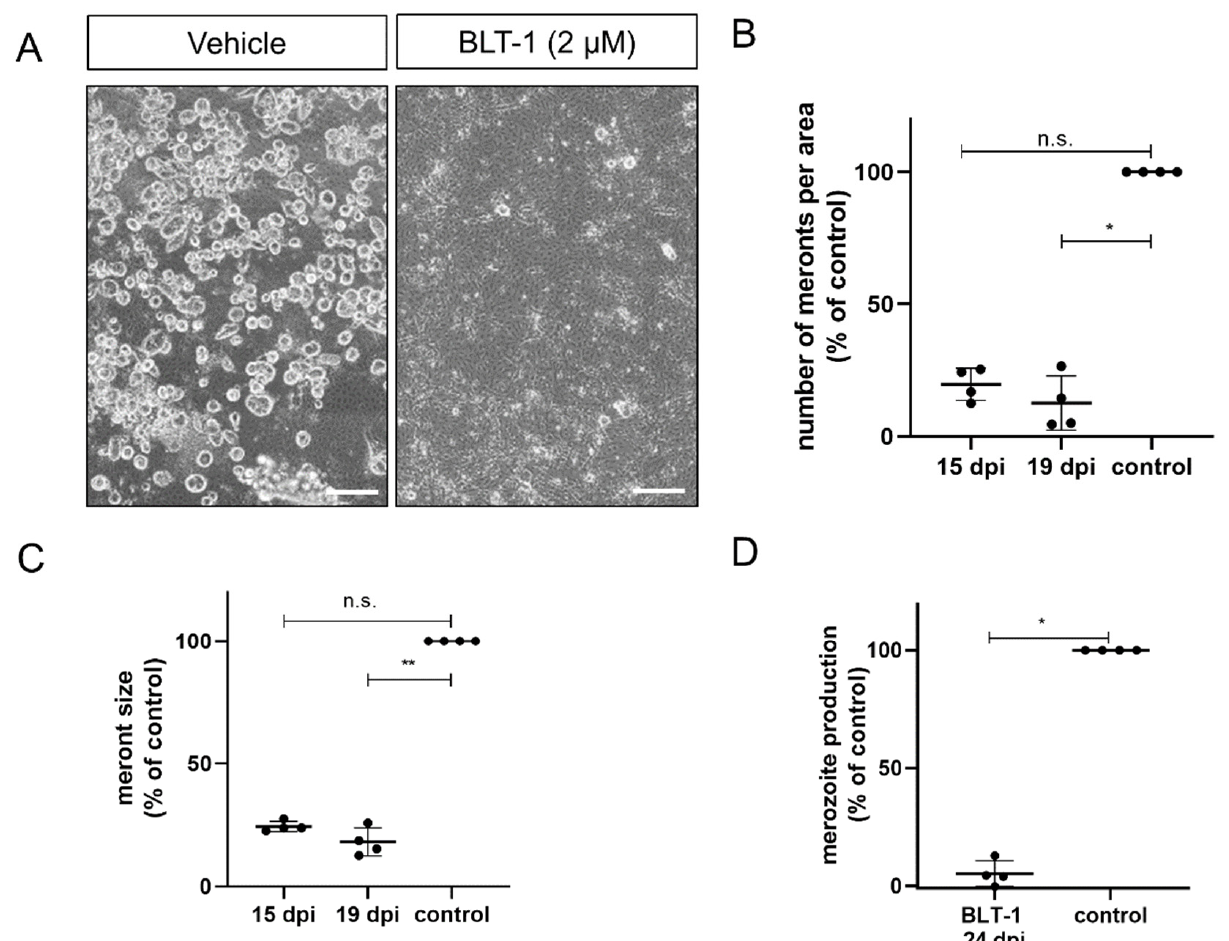
Figure 2. Inhibition of E. bovis macromeront development by BLT-1 treatments. ( A ) Representative illustration of E. bovis - infected primary bovine umbilical vein endothelial cells (BUVEC) treated with the vehicle or BLT-1 at day 19 p.i. Normalized number of macromeronts ( B ) and macromeront sizes ( C ) at days 15 and 19 p.i. in the vehicle- or BLT-1-treated E. bovis - infected BUVEC layers. ( D ) Normalized merozoite I production at day 24 p.i. in the vehicle- or BLT-1-treated E. bovis -infected BUVEC. Scatter plots illustrate the mean of four biological replicates ± standard deviation. Scale bar: 200 µ m. * p ≤ 0.05; ** p ≤ 0.01.